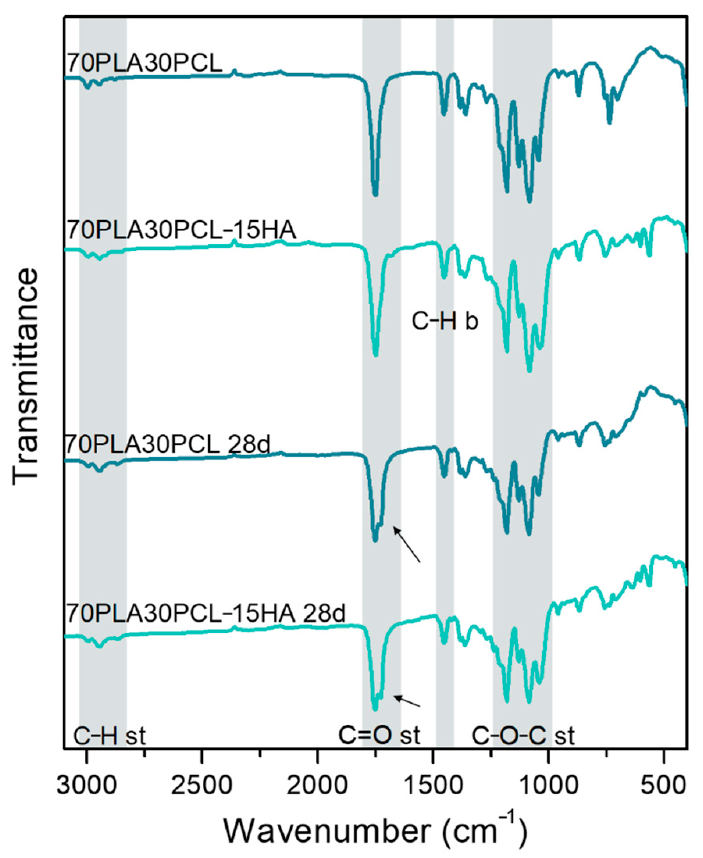
Figure 5. Comparison between IR spectra obtained before and after 28 days of degradation of the 70PLA30PCL blend and the 70PLA30PCL-15HA composite.